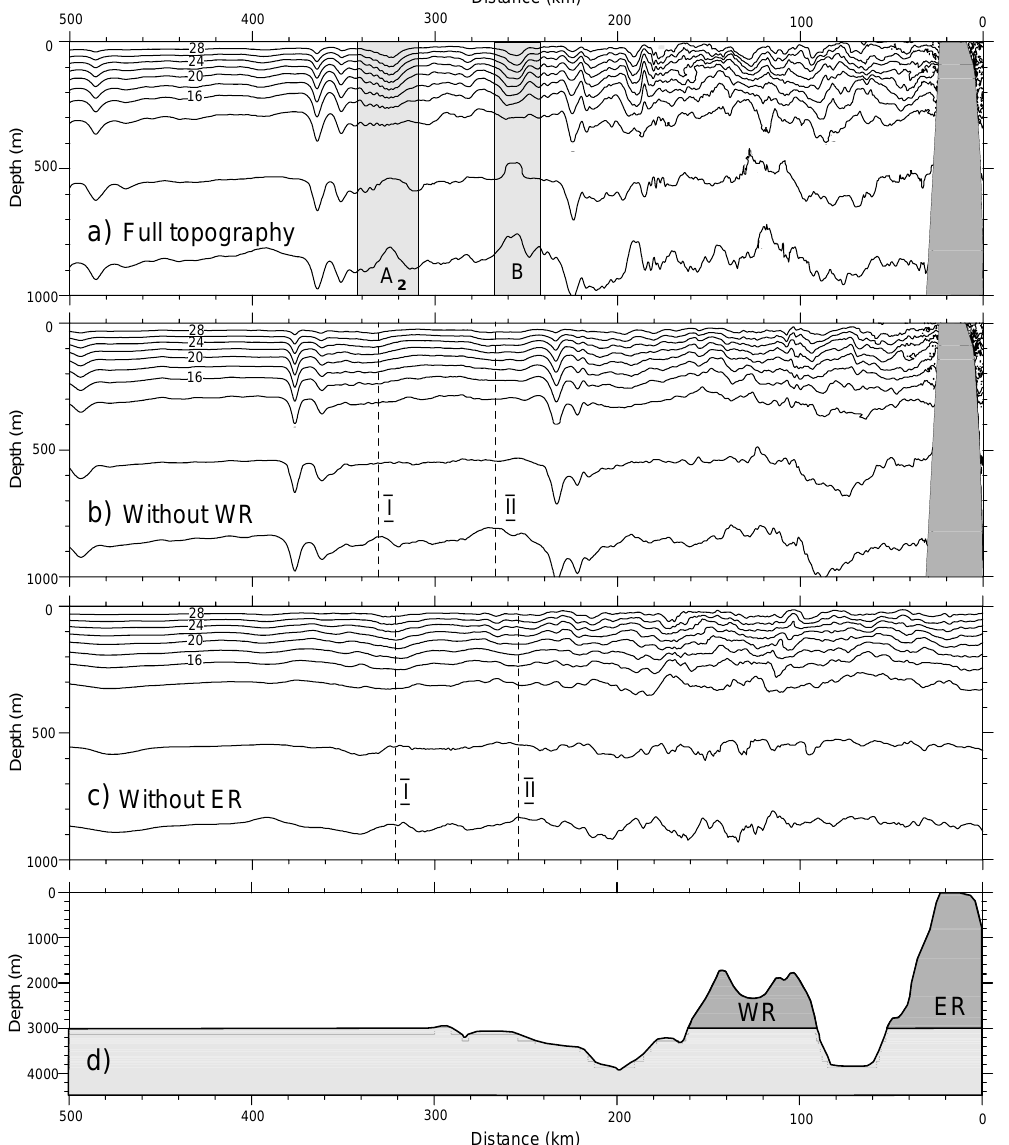
Fig. 11. Model-predicted temperature fields in the cross-section (b), Fig. 3, after five tidal cycles calculated for (a) real topography, (b) without western ridge, and (c) without eastern ridge. The three bottom profiles are shown in panel (d) . baroclinic tidal signals generated over eastern and